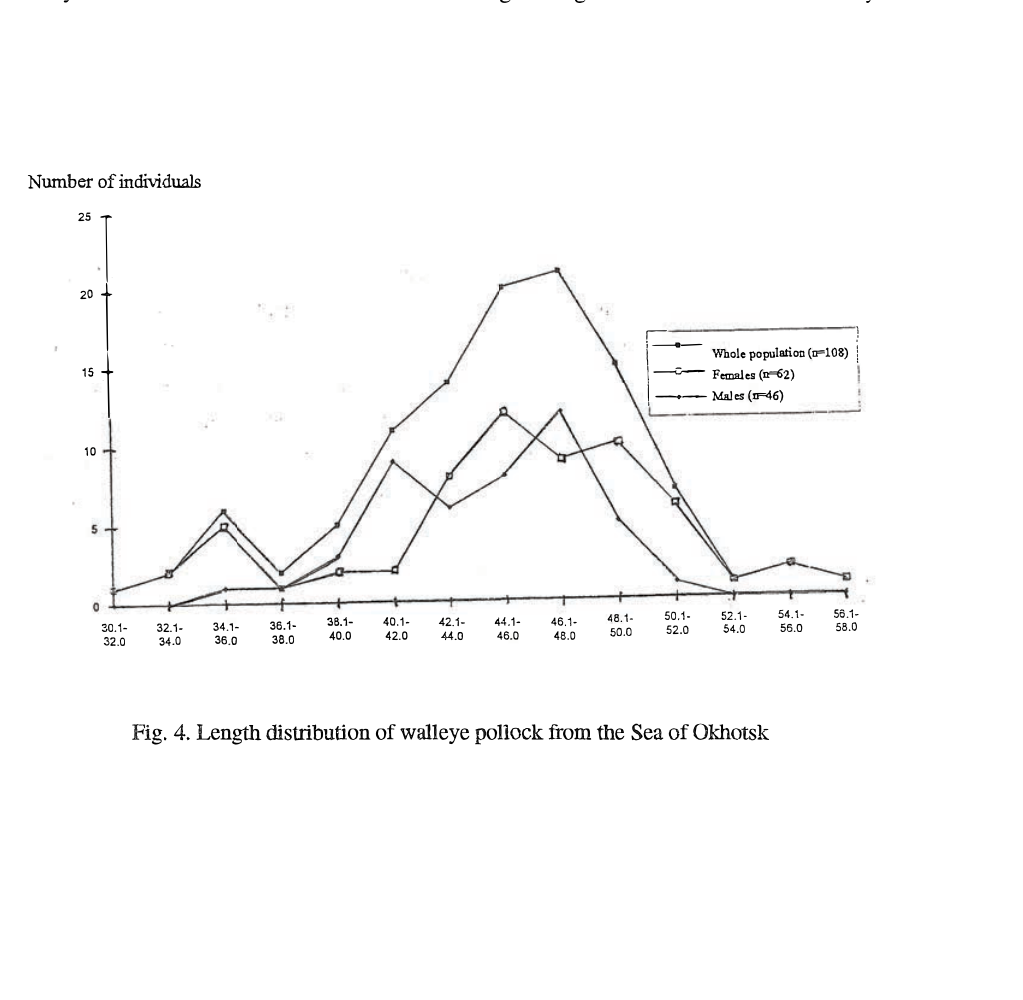
Fig. 4. Length distribution of walleye pollack from the Sea of